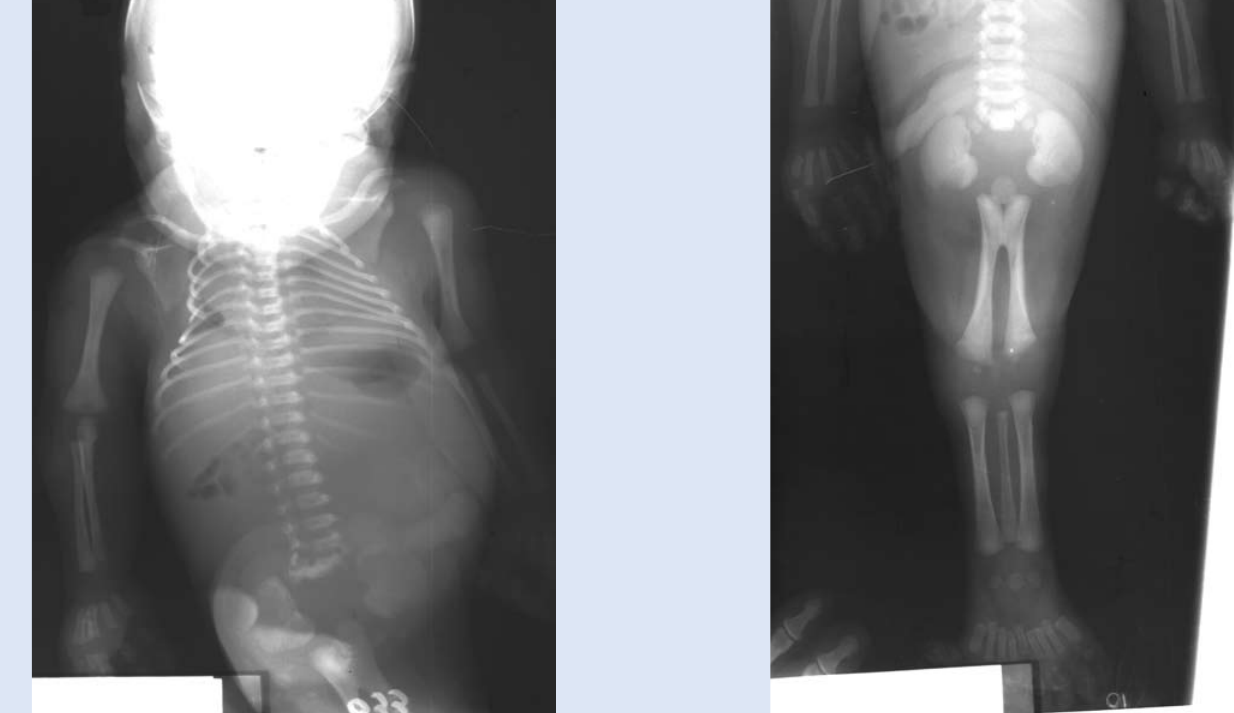
Fig. 2. Antero-posterior radiographs of the upper chest and abdomen and the lower extremities show complete fusion of the lower limbs and feet with 2 femurs, 2 tibiae and a single fibula. There is fusion of both feet, which partially concurs with symelia limbus. Note also the dysgenesis of the pubic and ischial bones and agenesis of the